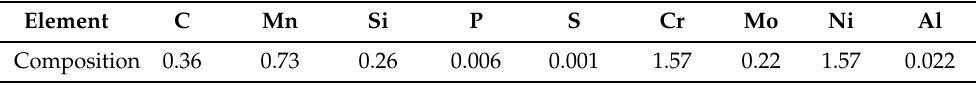
Table 2. Chemical composition (in % of weight) of the tested material 34CrNiMo6 [39].